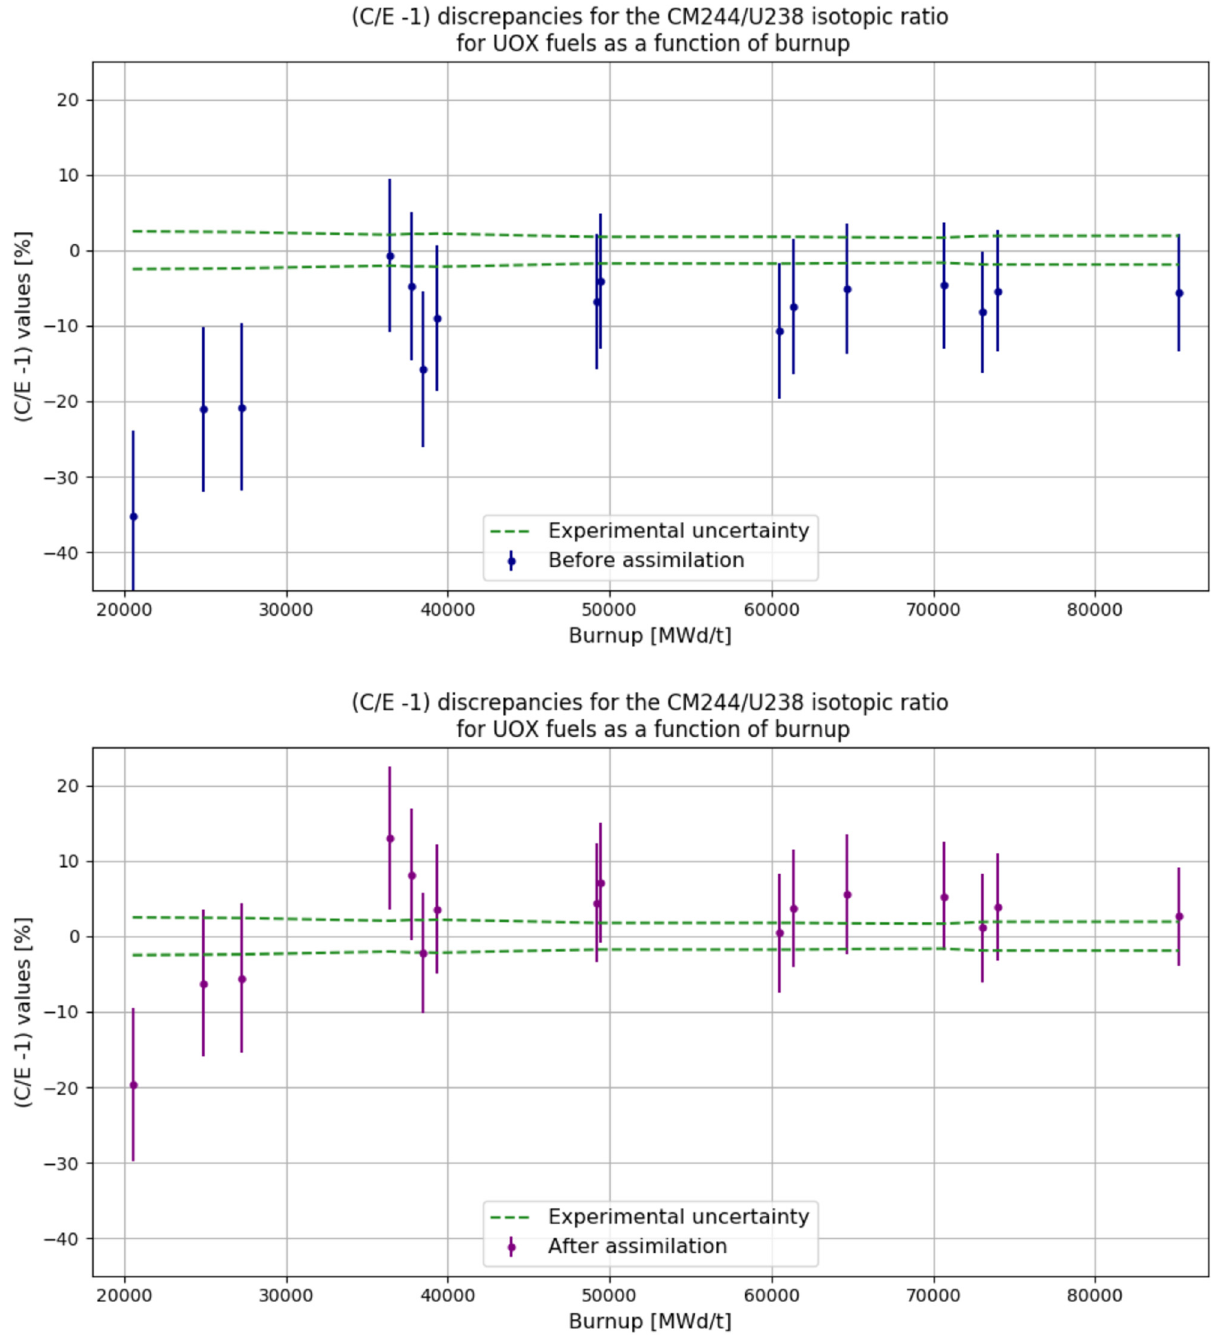
Fig. 8. Evolution of the calculated-to-experimental discrepancies before and after integral data assimilation for the 244 Cm/ 238 U isotopic ratio in UOX